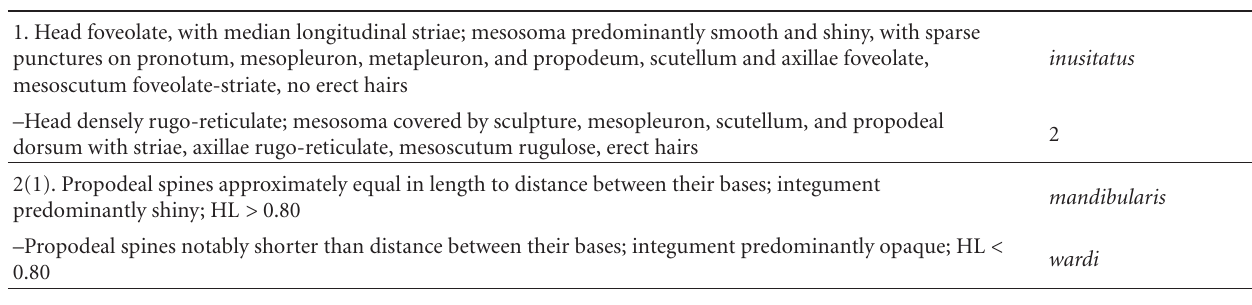
Table 2: Key for the known queens of Lenomyrmex